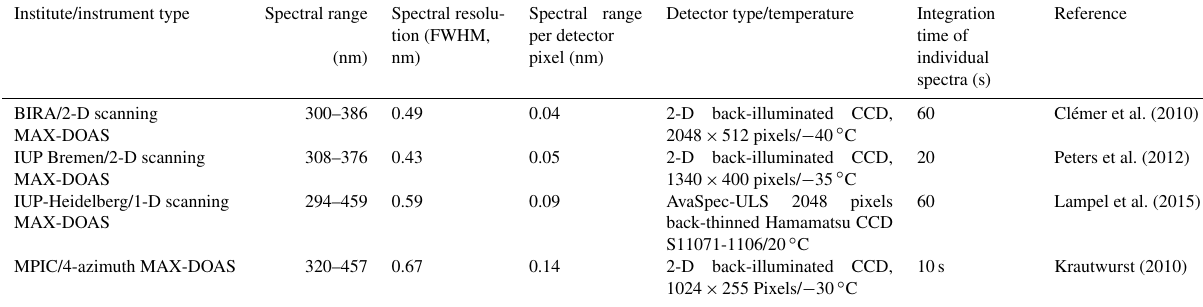
Table 4. Overview of properties of MAX-DOAS instruments participating in this study.